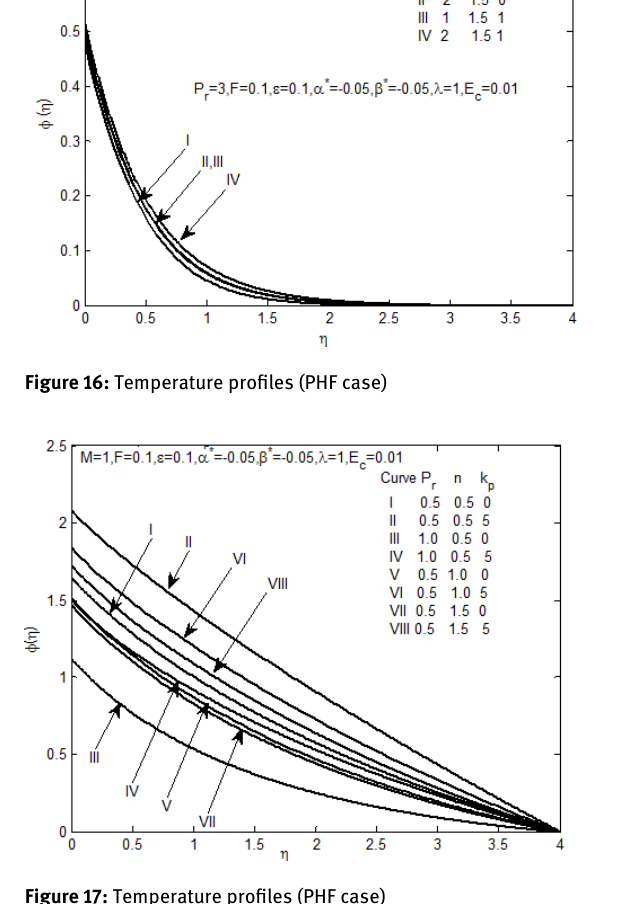
profiles whereas reverse effect is encountered for the in- creasing values of power index. All profiles exhibit fall of